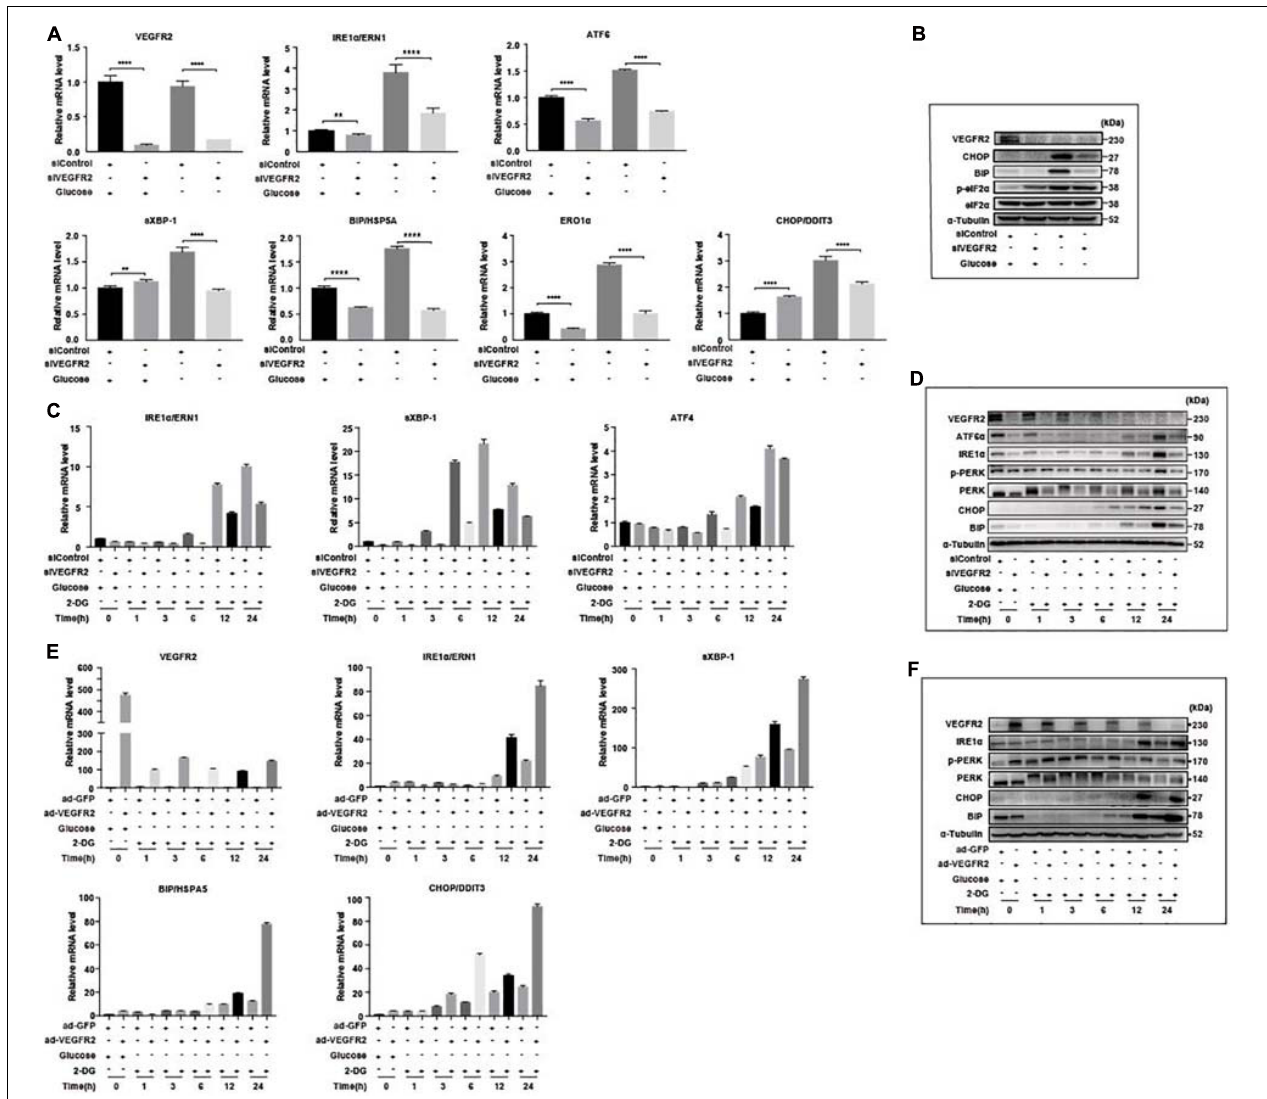
FIGURE 3 | Level of VEGFR2 determined ER stress and UPR. (A) VEGFR2 knockdown via siRNA decreased glucose-depletion-mediated ER stress, as indicated by the UPR markers at the RNA level in primary hRPE cells. (B) VEGFR2 knockdown decreased the ER stress markers at the protein level in primary hRPE cells. (C) Time-course of the markers of glucose-depletion-mediated ER stress that was affected by VEGFR2 knockdown at the RNA level in ARPE-19 cells. (D) Time-course of the markers of glucose-depletion-mediated ER stress that was affected by VEGFR2 knockdown at the protein level in ARPE-19 cells. (E) Time-course of the markers of glucose-depletion-mediated ER stress that was affected by VEGFR2 overexpression at the RNA level in ARPE-19 cells. (F) Time-course of the markers of the glucose-depletion-mediated ER stress that was affected by VEGFR2 overexpression at the protein level in ARPE-19 cells. All error bars indicate S.D. ** P < 0.01, **** P <